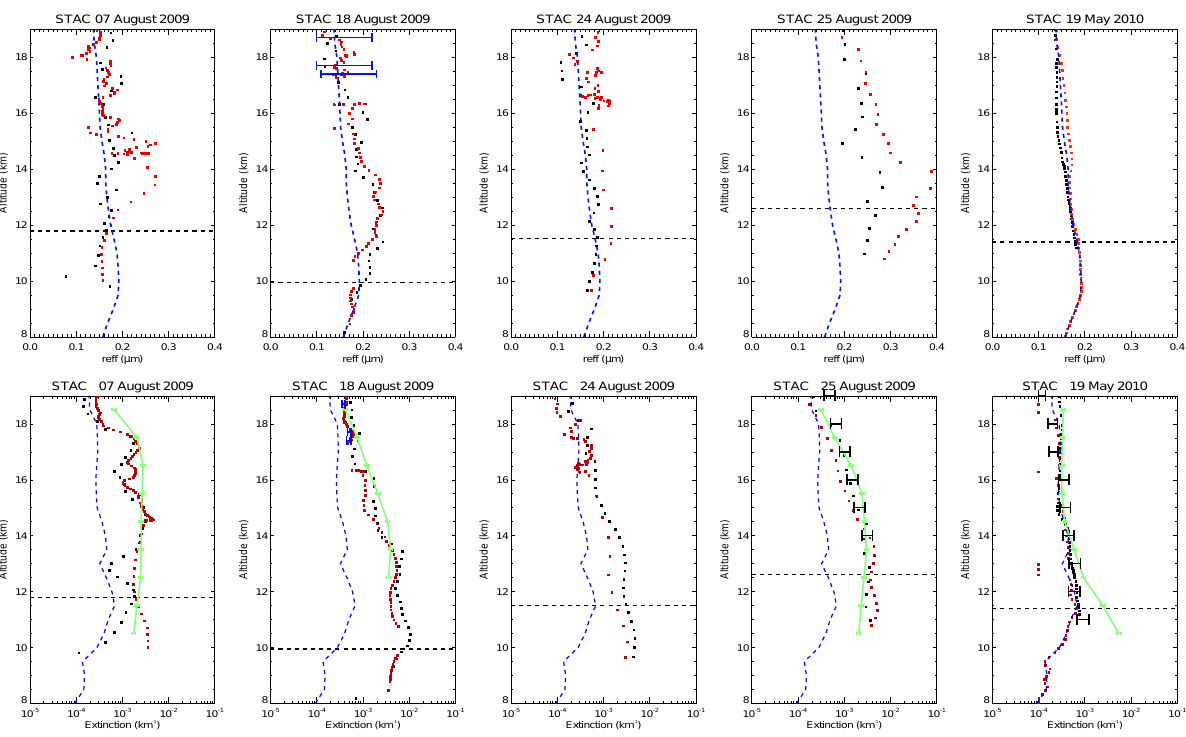
Fig. 11. Observations by the STAC aerosol counter for effective radius (top) and aerosol extinction coefficient at 740nm (bottom) on 7, 18, 24, and 25 August 2009 (volcanic conditions) and on 19 May 2010 (background conditions) for the balloon ascent (black squares) and descent (red squares). Dashed blue lines: STAC background profiles on 19 May 2010 averaged over the whole flight (ascent and descent). Horizontal blue lines: MicroRADIBAL effective radius and extinction coefficient at 740nm in the 17–19km range on 18 August 2009. Extinction: OSIRIS profiles (green lines) at 750nm; SALOMON balloon observations (horizontal black lines) at 750nm on 25 August 2009 and on 28 April 2011 (shown on the 19 May 2010 figure). Horizontal black dotted lines: thermal tropopause derived from collocated balloon soundings. See Sect. 6 for